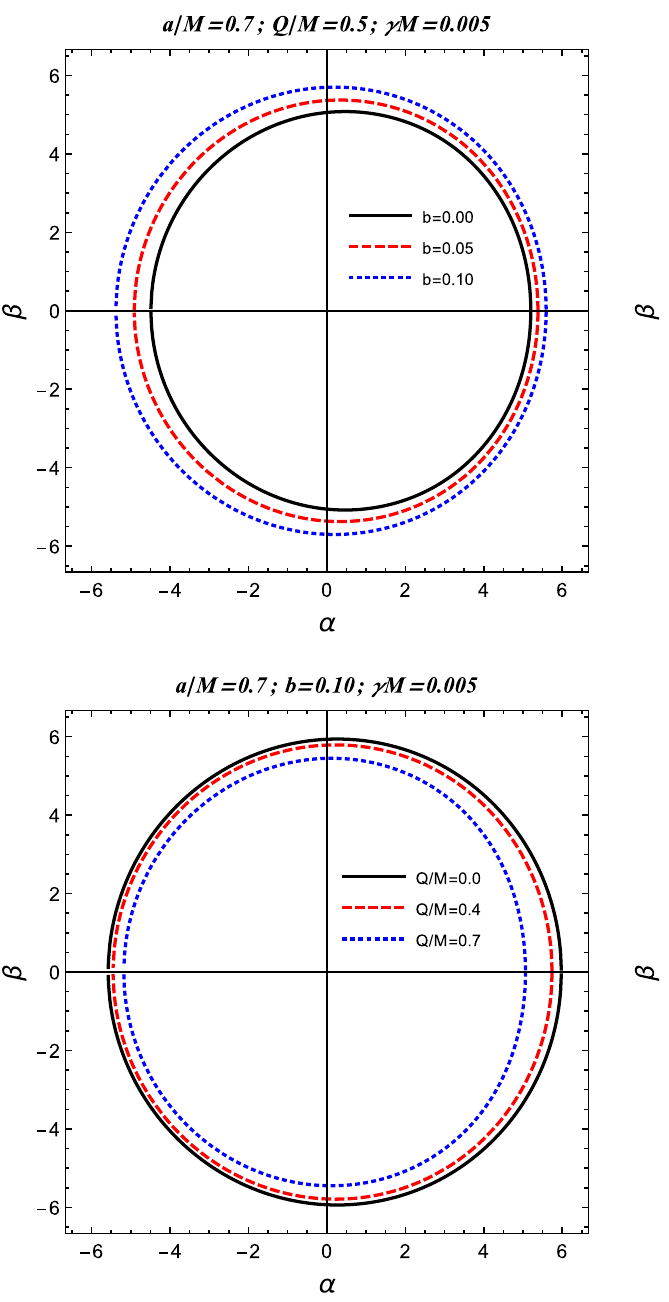
Fig. 3 Shadow cast by the Kerr–Newman–Kiselev–Letelier black hole